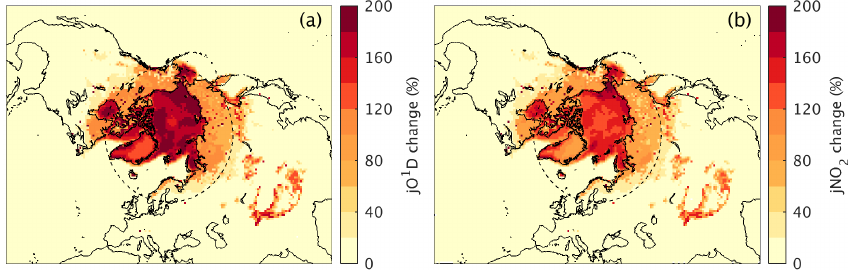
Figure 4. Change in (a) j O 1 D and (b) j NO 2 photolysis rates at the surface due to the implementation of an UV-albedo dependence on snow and ice cover in the Fast-J scheme (April 2008 average, ALL_UPDATES –